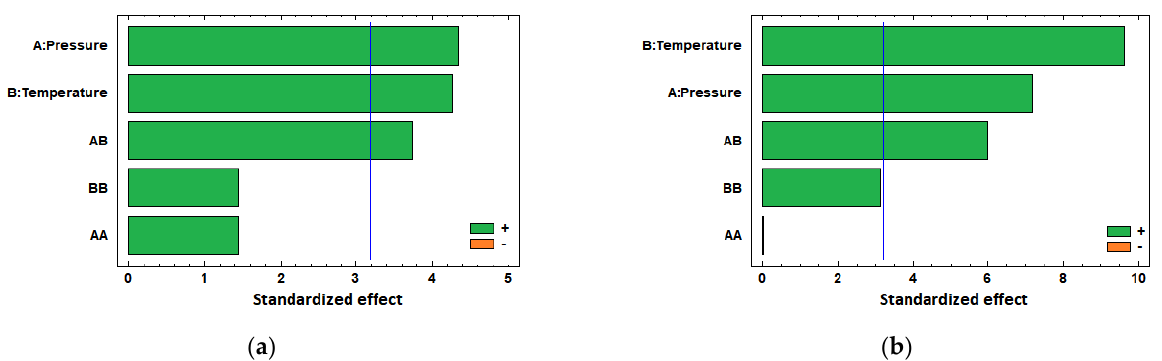
Figure 3. Standardized Pareto charts of the swelling of PLA filaments, ( a ) under CO 2 supercritical conditions and ( b ) scCO 2 -assisted impregnation with ketoprofen . Table 2. ANOVA table showing the swelling of PLA filaments under supercritical conditions.